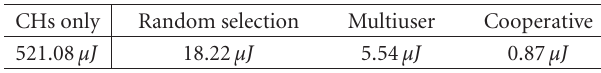
Figure 7: The coalition sizes. Table 3: The energy consumption of all the schemes. CHs only Random selection Multiuser